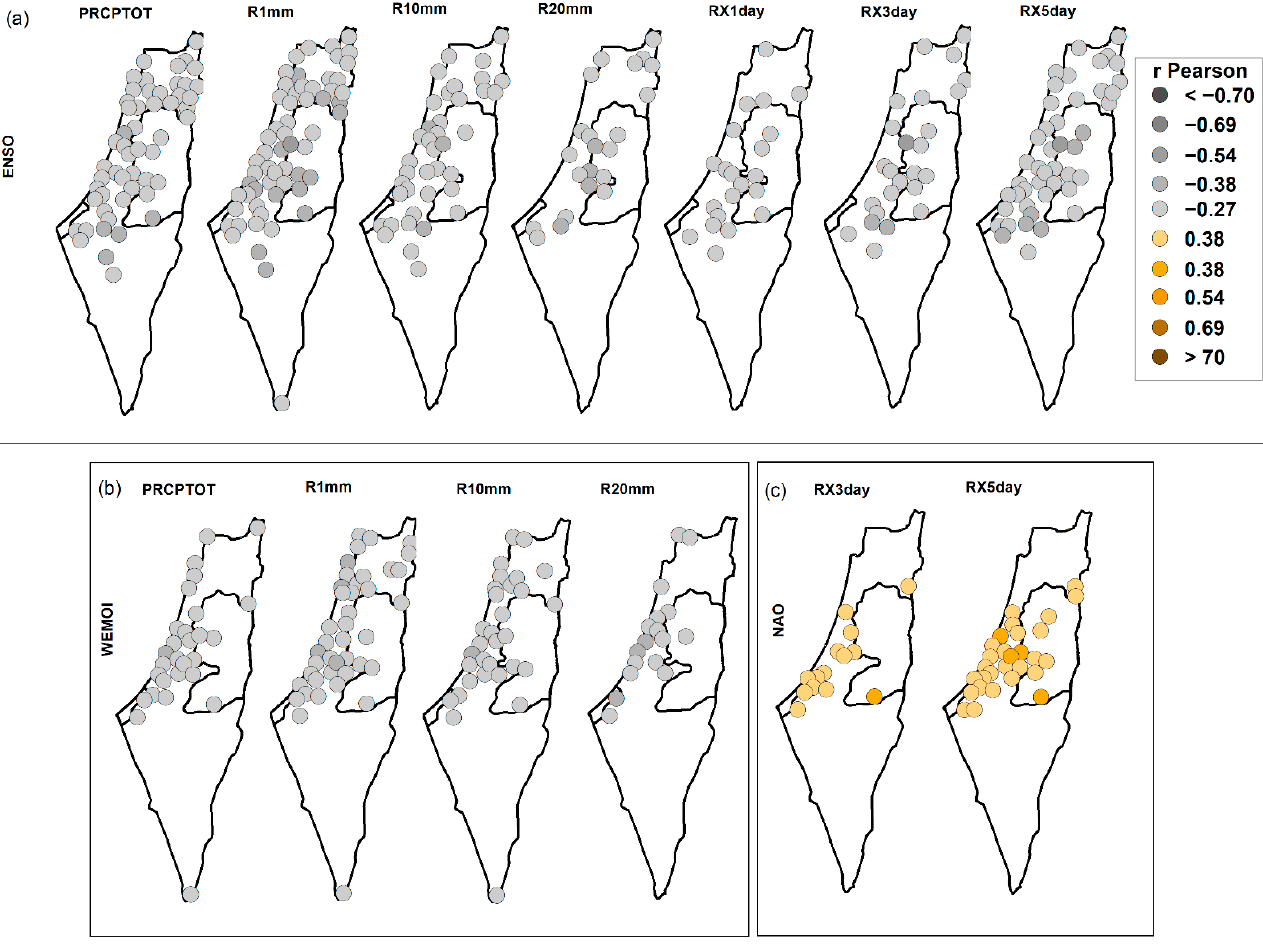
Figure 9. Spatial distribution of significant Pearson correlation coefficients between the teleconnection indices (ENSO, WEMOI, and NAO) and the extreme precipitation indices (PRCPTOT, R1mm, R10mm, R20mm, RX1 day, RX3 day, and RX5 day), in autumn.